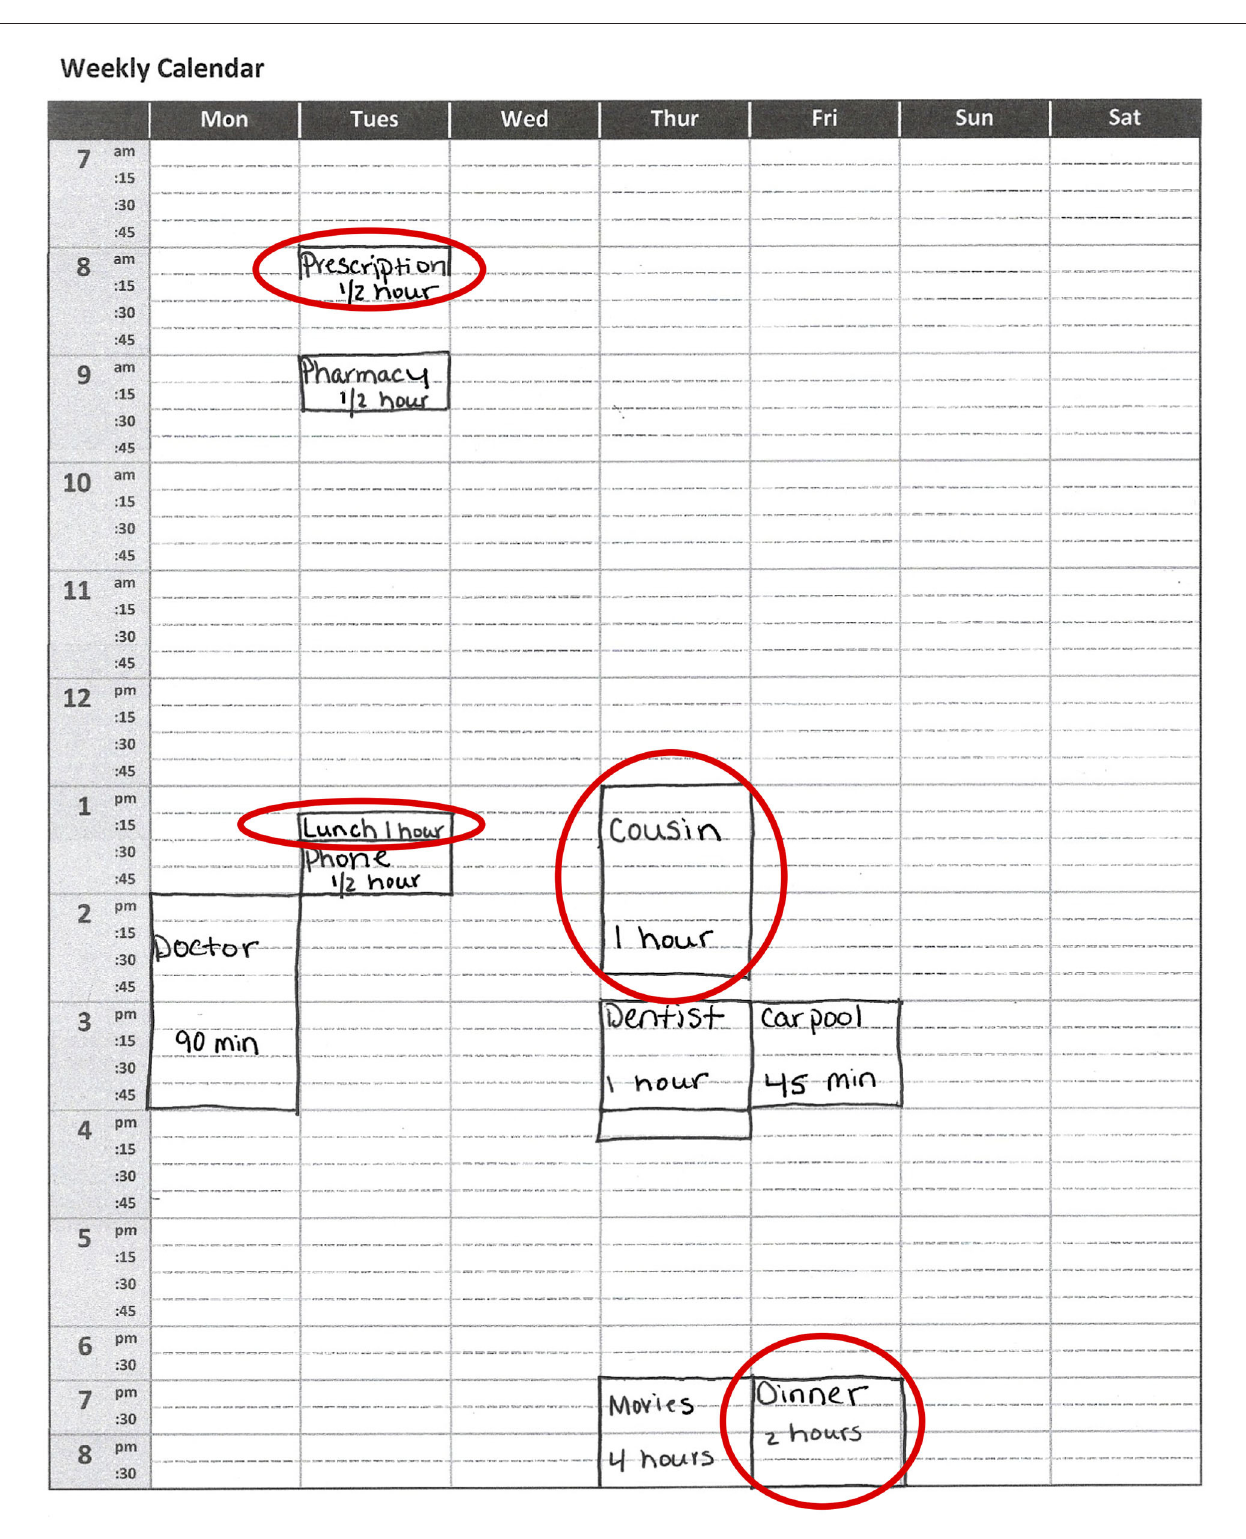
Frontiers in Neurology | www.frontiersin.org 4 July 2021 | Volume 12 | Article